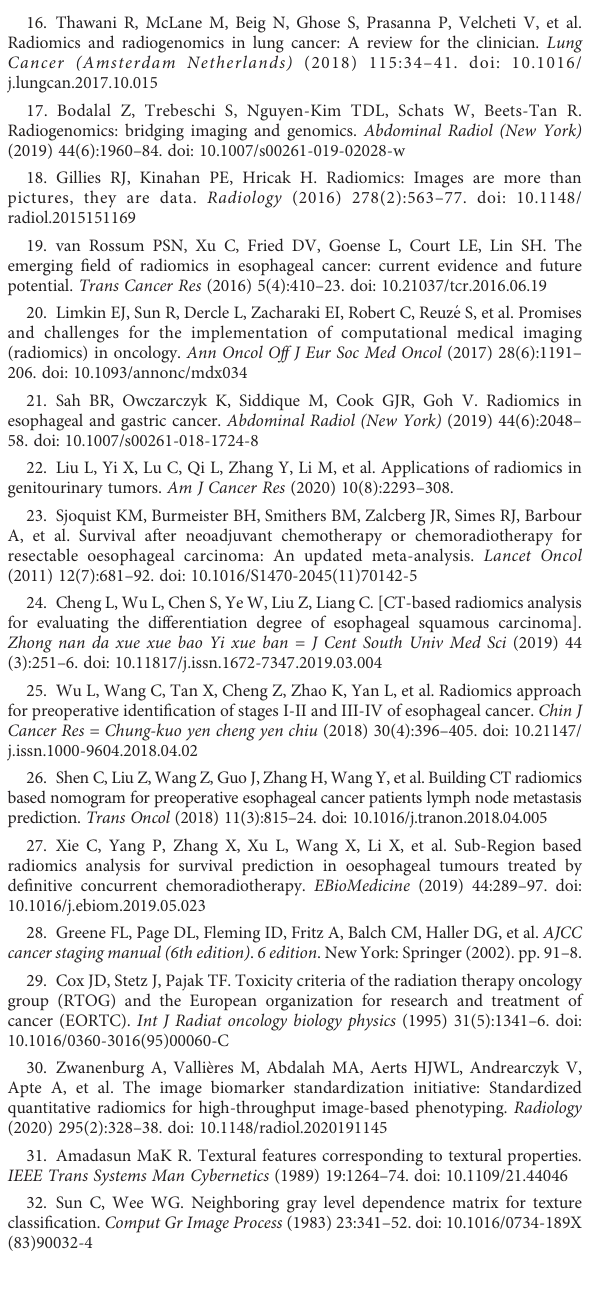
SUPPLEMENTARY FIGURE 2 The changein themeanesophageal stenoticratioof48 patients from3to 18 months after treatment. Six points in x axis represent 3, 6, 9, 12, 15, and 18 months after completing